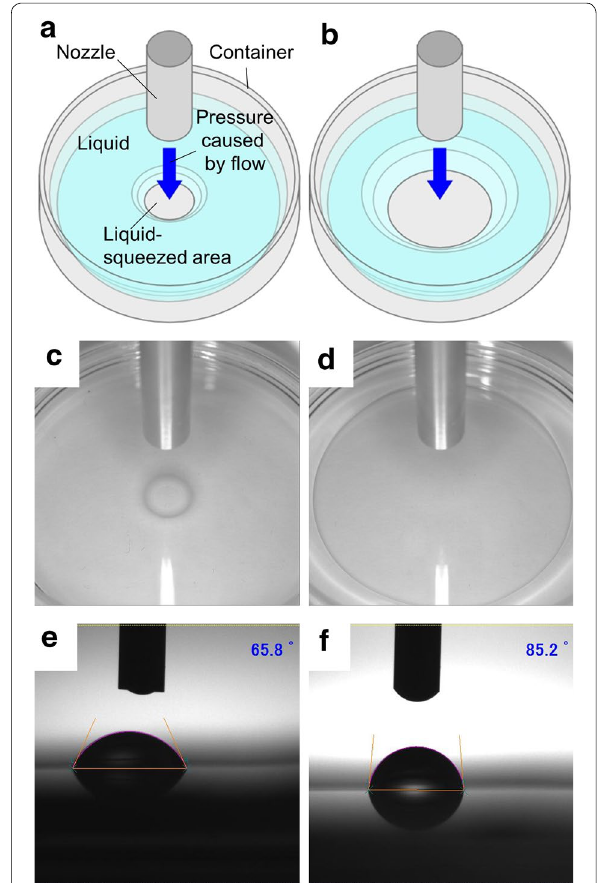
Fig. 1 Surface wettability assessment based on liquid squeezing by a jet flow. Schematic illustrations a , b show the liquid squeezing on hydrophilic and hydrophobic surfaces, respectively. Photographs c , d show the behaviors of ultra-pure water squeezed by an air-jet flow on hydrophilic and hydrophobic surfaces, corresponding to the contact angles of 65.8° ( e ) and 85.2° ( f ),